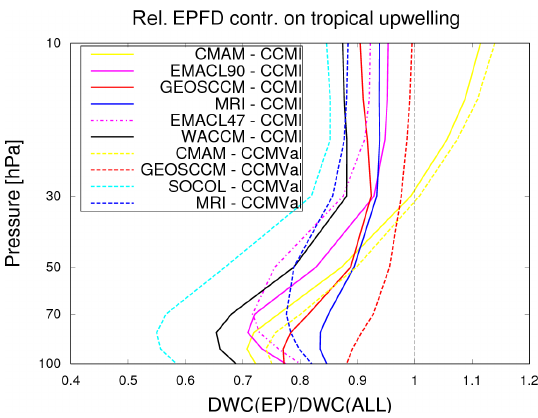
Figure 8. Relative EPFD contribution on tropical upwelling (cal- culated as EPFD contribution of downward control calculated trop- ical upwelling divided by overall tropical upwelling) 30 ◦ N–30 ◦ S as function of pressure for all CCMVal-2 and CCMI-1 models pro- viding the data for this